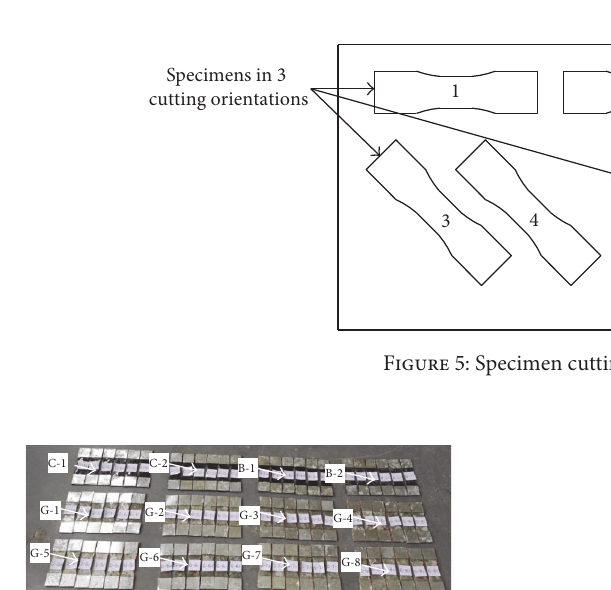
Figure 4: Dimensions of the actual specimens.